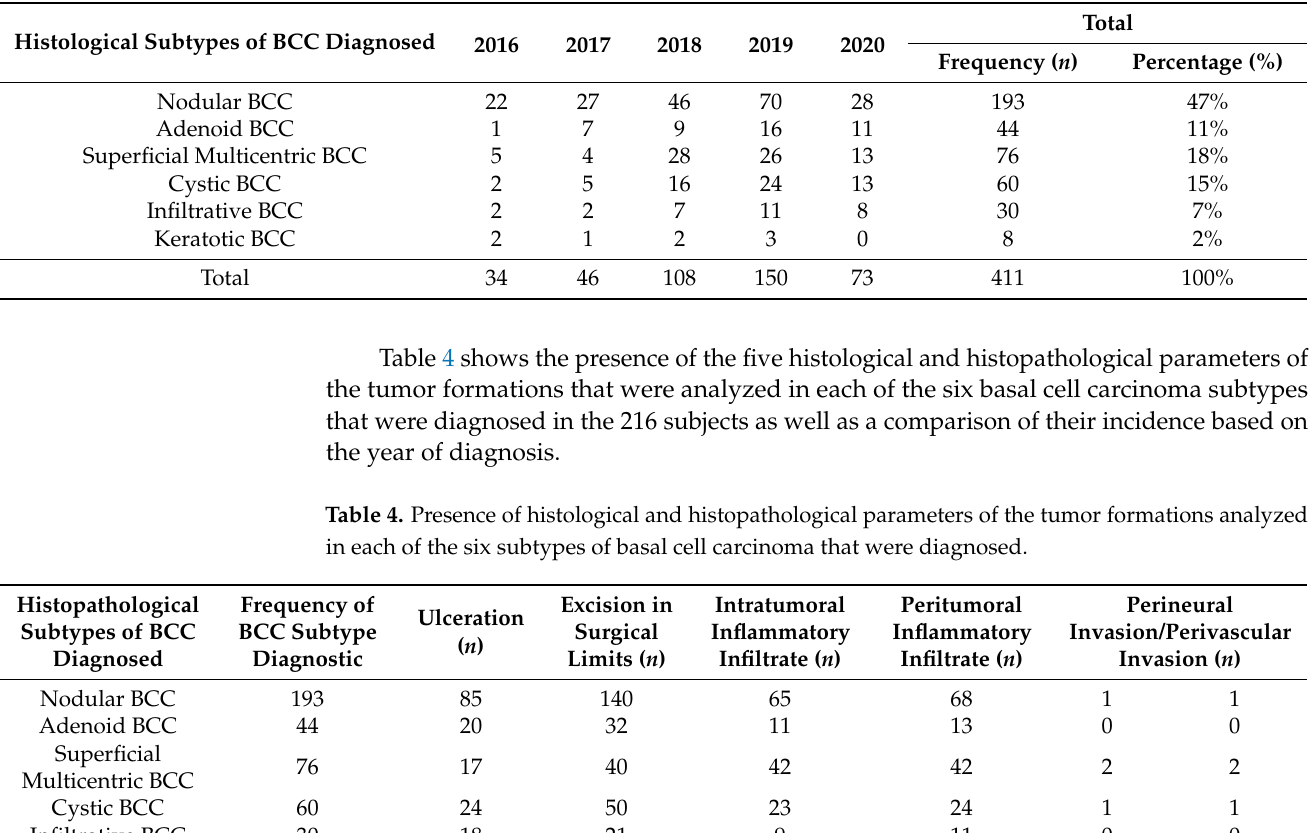
Table 3. Distribution of all histopathological subtypes of BCC diagnosed and comparison of their annual incidence.